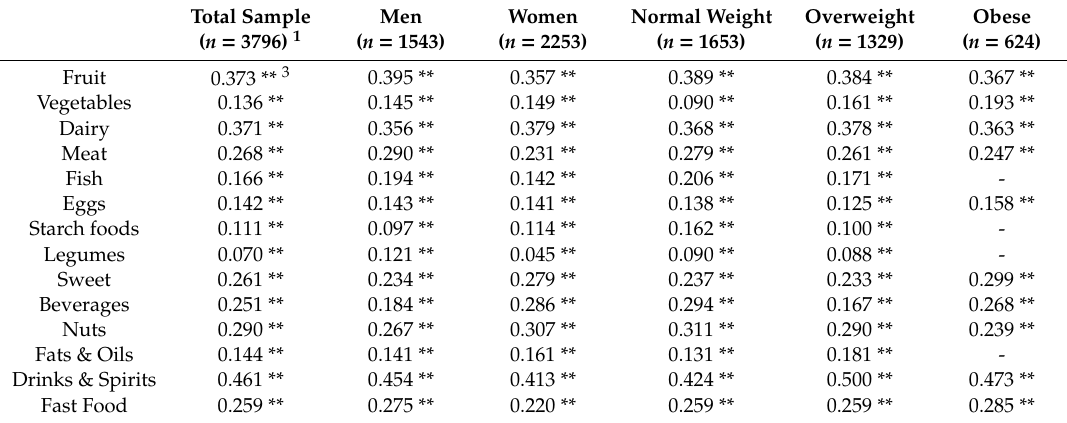
Table 4. Spearman’s correlation coe ffi cients for Validity of FPQ 2 versus 24 hR, by subgroups of